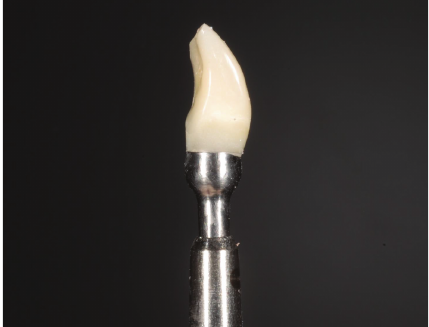
Figure 20: The provisional integrated abutment crown before fixation.